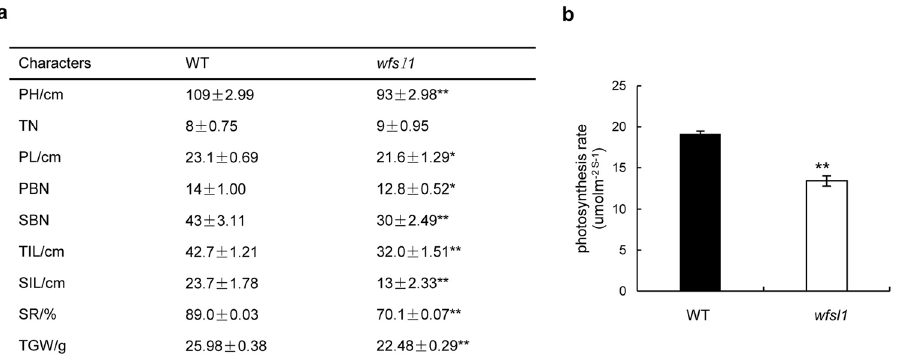
Figure 3. Agronomic traits and photosynthesis analysis of wild type and wfsl1 plants. ( a ) Agronomic traits analysis of wild type and wfsl1 . ( b ) Photosynthesis rate analysis of wild type and wfsl1 at tillering stage. PH Plant height. TN Tiller number. PL Panicle length. PBN Primary branch number. SBN Second branch number. TIL Topmost internode length. SIL Secondmost internode length. SR Setting rate. TGW thousand grain weight. Error bars represent the SD from three independent experiment (Student’s t -test, * P < 0.05; ** P < 0.01; n =